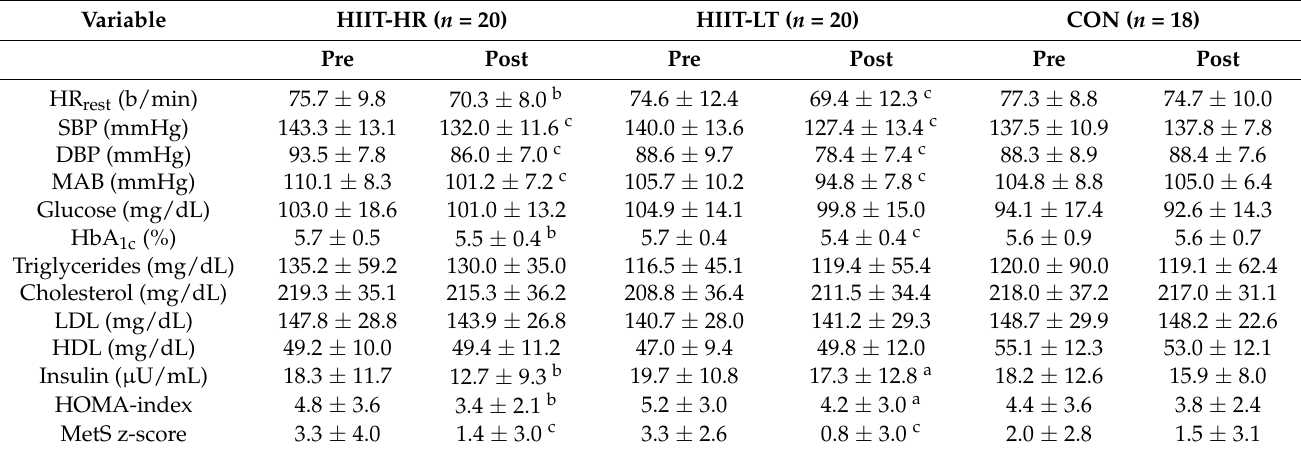
Table 5. Cardiometabolic variables.